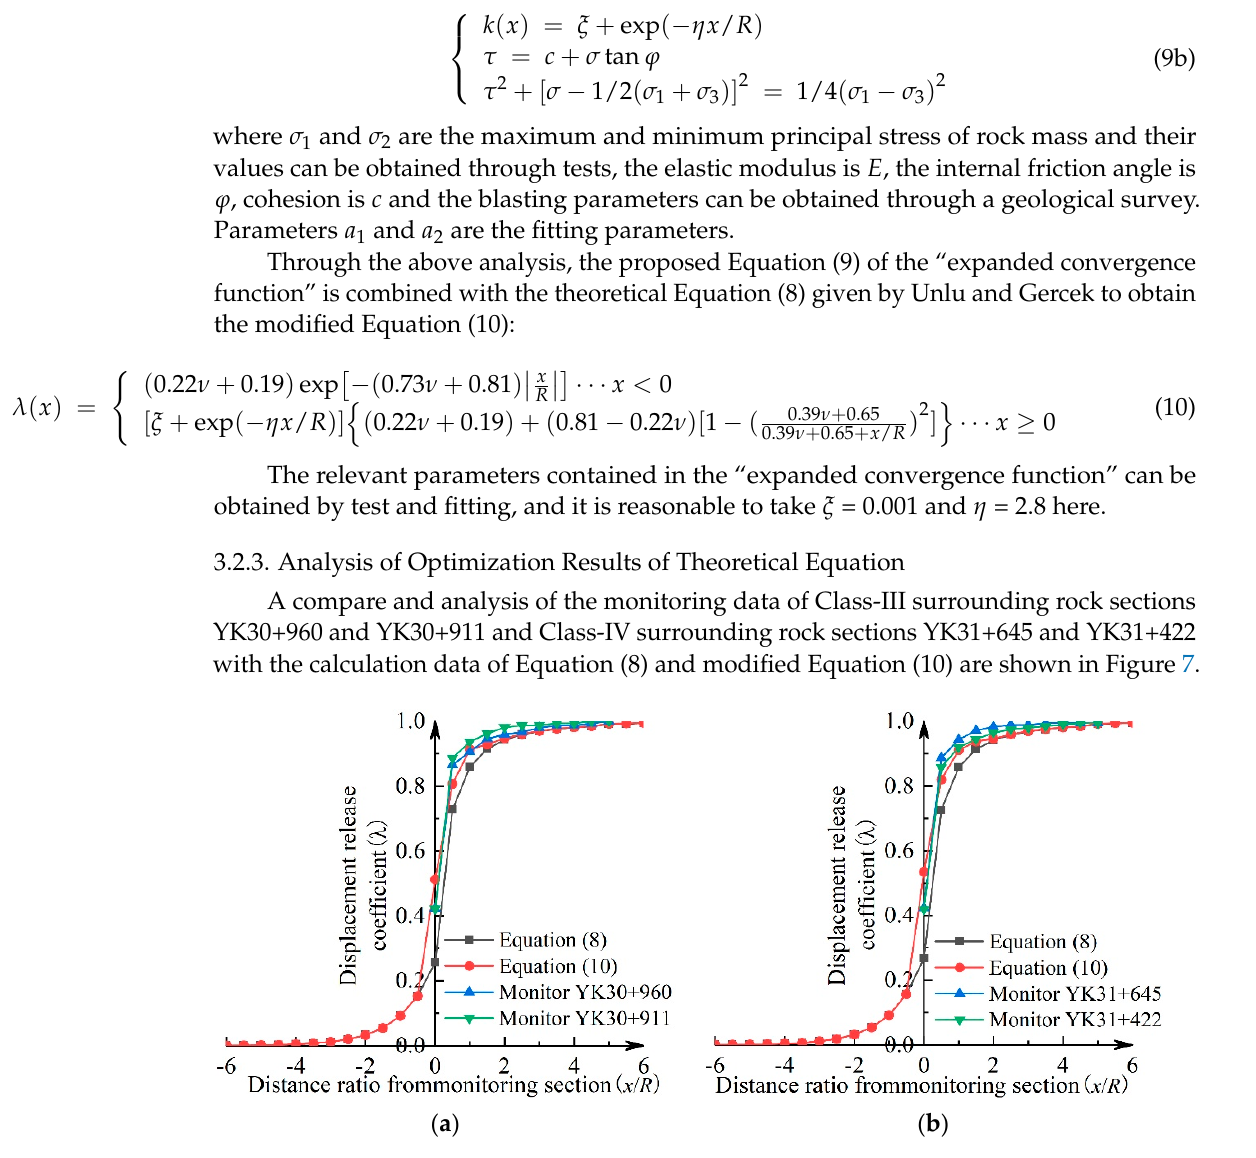
Figure 7. Monitoring and theoretical fitting diagram of vault displacement release coefficient: ( a ) Class − III surrounding rock; ( b ) Class − IV surrounding rock.